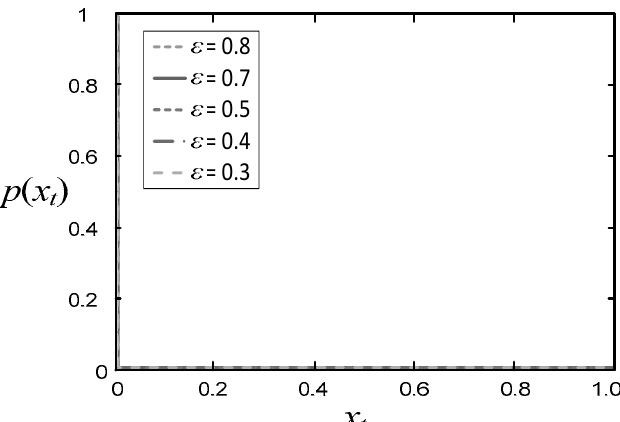
Figure 6. The simulation result of the original four stage CML based on the tent map.